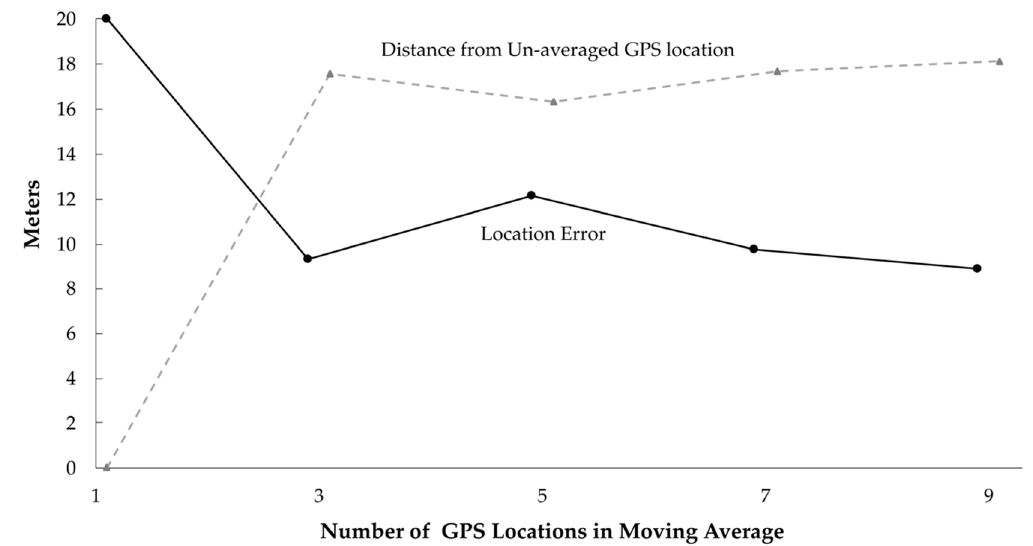
Figure 3. Sensitivity analysis to compare how averaging a single screened GPS location with surrounding locations (a moving average) reduces location error while moving each individual location a distance away from the un-averaged location. GPS stationary test data was collected during the summer of 2015 and 2016 in northeastern Minnesota in commonly used wood turtle ( Glyptemys insculpta ) habitat. The number of GPS locations in the moving average was 3, 5, 7, or 9, and the location error was the distance from each final (i.e., screened and averaged) location to the true location. The distance from the un-averaged GPS location is how far the location was shifted by the moving average. For both location error and distance from un-averaged GPS location the SE is smaller than the symbol.